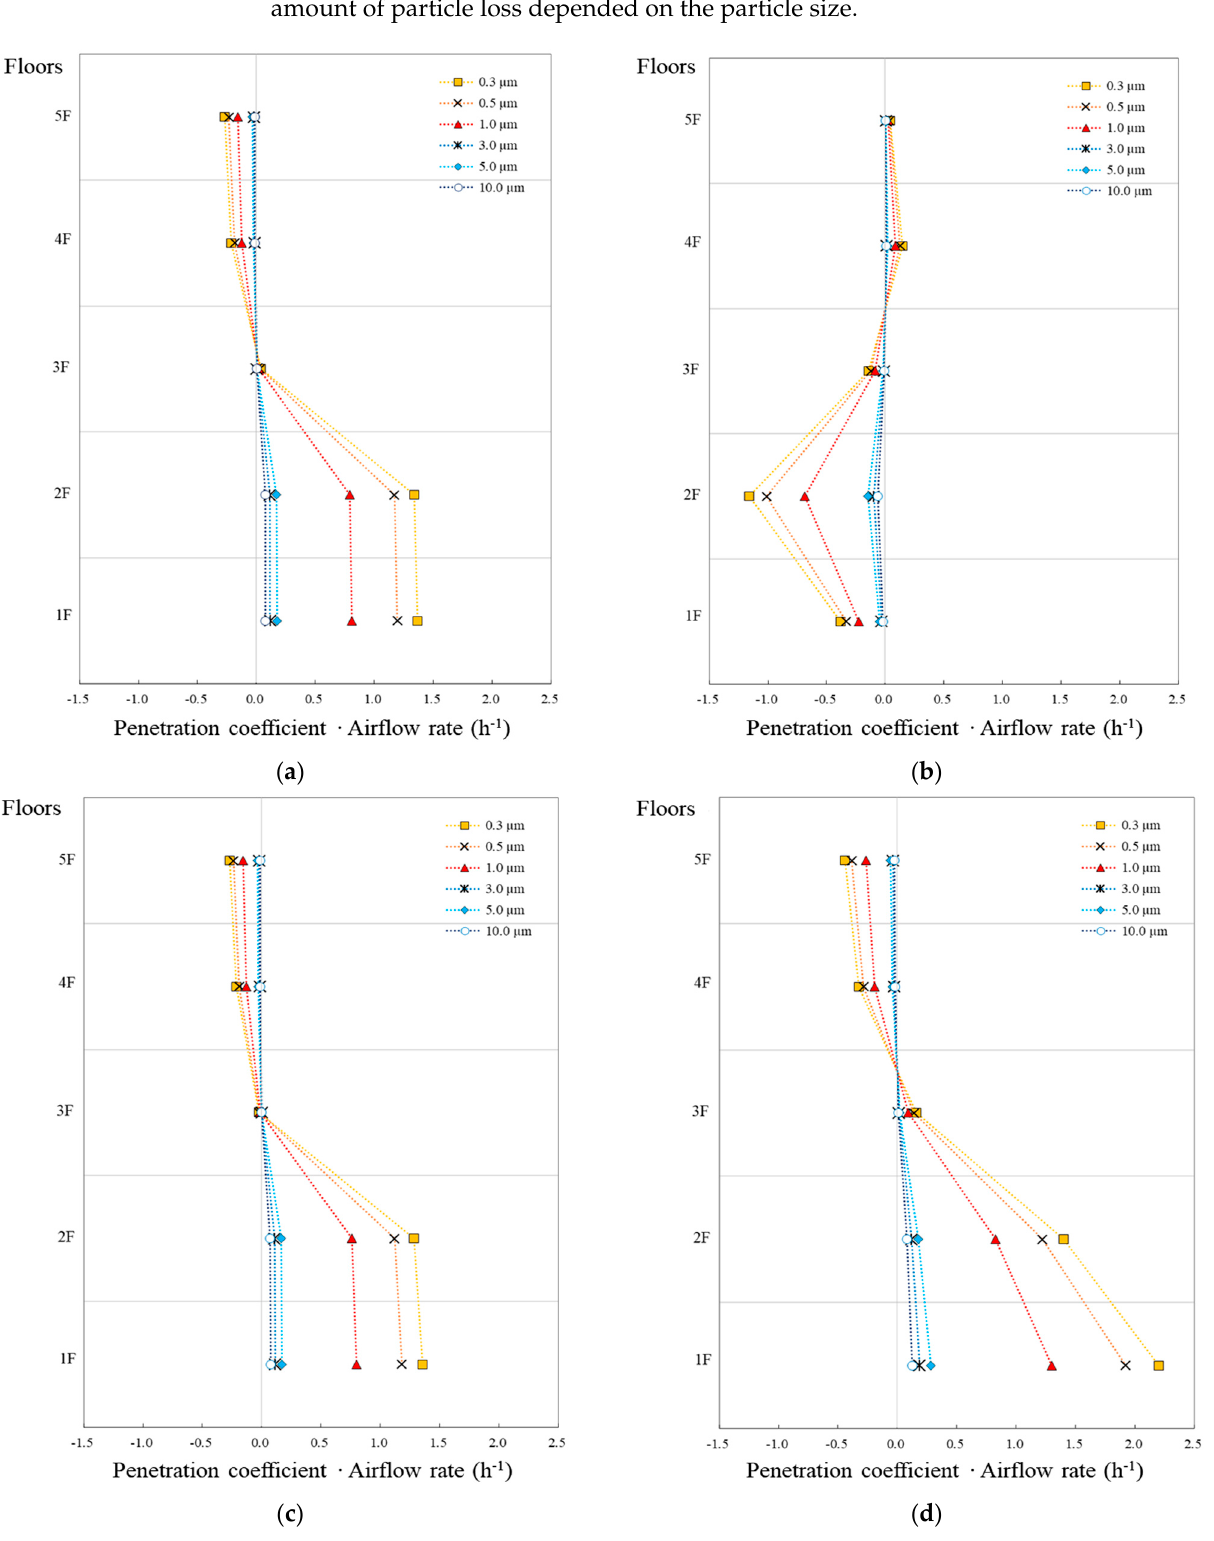
Figure 9. Amount of particle penetration through the reference-building envelope: ( a ) case 1, spring; ( b ) case 2, summer; ( c ) case 3, autumn; ( d ) case 4, winter. In the analysis of the inflow and outflow of particles from the outdoors, (+) and ( − )were used to express the directions of inflow and outflow. For each season, the inflow and outflow of outdoor particles were similar to the airflow pattern. In spring, autumn, and winter, outdoor particles flowed through the lower floor and out through the upper